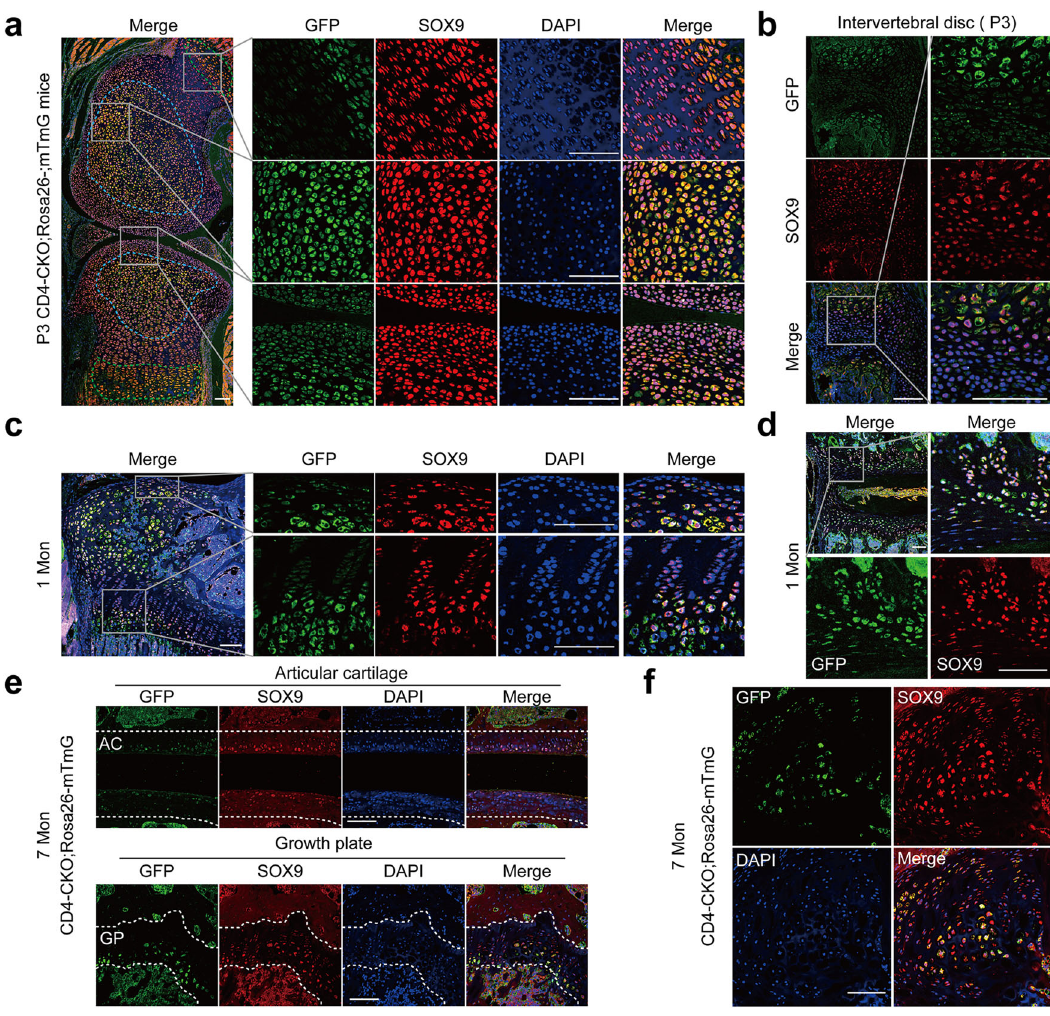
Fig. 4 CD4-Cre mediates conditional deletion of SHP2 in chondrocytes. Sagittal section of joints from CD4-CKO; Rosa26-mTmG mice were immunostained with marker protein GFP, transcriptional regulator SOX9 and nuclear counterstain DAPI. a , b Immuno fl uorescence staining images show SOX9 expression in all chondrocytes and GFP expression in hypertrophic chondrocytes in knee and spine section of P3 CD4-CKO; Rosa26-mTmG mice. a Blue dotted box shows cartilage mold, and green dotted box indicates hypertrophic zone of the growth plate. c , d Representative images of 1-month-old CD4-CKO; Rosa26-mTmG mice show GFP + chondrocytes consisted in hypertrophic zone of femur and spine. e , f Immuno fl uorescence analysis of articular cartilage and growth plate ( e ) and chondroma ( f ) of the tibia in 7-month-old CD4-CKO; Rosa26-mTmG mice show GFP + differentiated chondrocytes in the growth plate and articular cartilage of mature CD4-CKO;Rosa26-mTmG mice. e The area inside the two white dotted lines is articular cartilage (AC) (upper) and growth plate (GP) (under). a – f Scale bars, 100 μ m. Data are representative of three independent